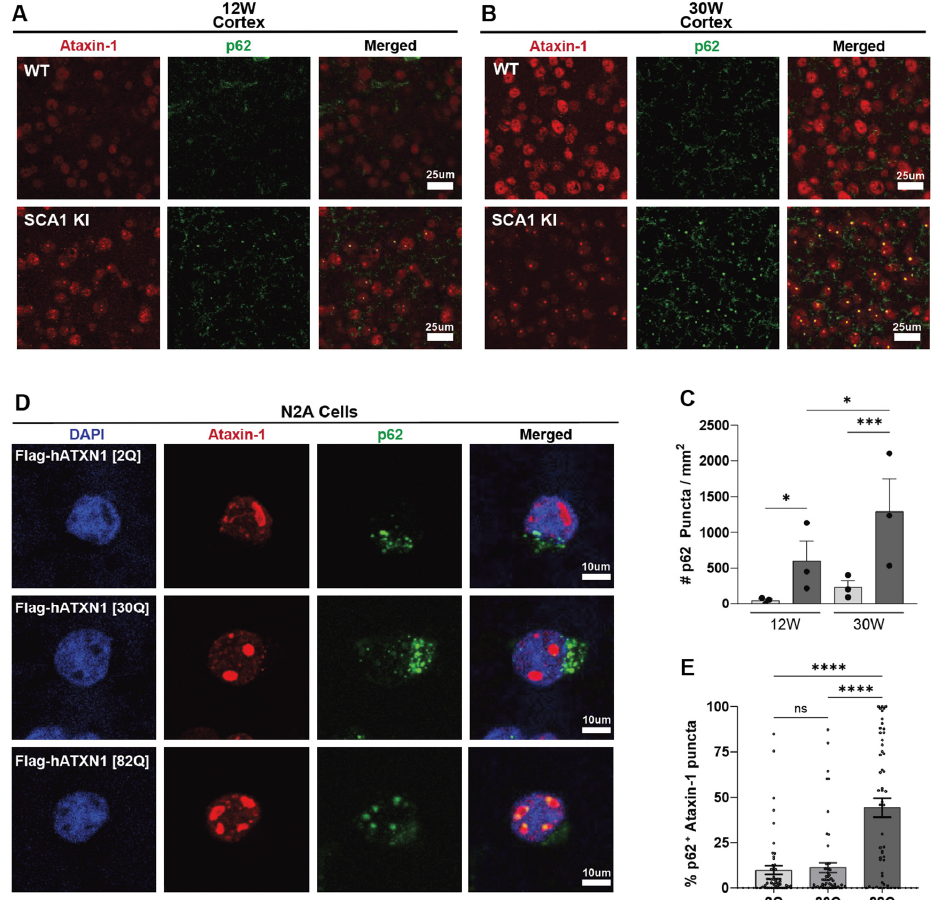
Figure 2. p62-positive aggregates are progressively upregulated and colocalize with ataxin-1 nu- clear inclusions in the SCA1 KI mouse cortex. ( A , B ), Representative images of SCA1 KI and WT control motor cortex at 12-weeks ( A ) and 30-weeks ( B ), stained with ataxin-1 [11NQ] antibody (red) to label ataxin-1 nuclear inclusions and with p62 (green), scale bar 25 μ m, quantified in ( C ). ( C ), Quantification of p62 puncta per mm 2 in the WT and SCA1 KI mouse motor cortex and 12- and 30- weeks (n = 3 animal per genotype, with 3 images per animal). ( D ), Representative images of N2A cells transfected with human Flag-hATXN1 [2Q] (top row), Flag-hATXN1 [30Q] (middle row), and Flag-hATXN1 [82Q] (bottom row), stained with DAPI (blue), ataxin-1 [11NQ] (red), and p62 (green) (scale bar 10 μ m), quantified in ( E ). ( E ), Quantification of p62-positive puncta colocalizing with ataxin-1 nuclear inclusions, plotted as % of cells with p62-positive ataxin-1 puncta, by polyQ length of ATXN1 plasmid (n = 50 cells per condition). (* p < 0.05, *** p < 0.001, **** p < 0.0001, ns = not significant).